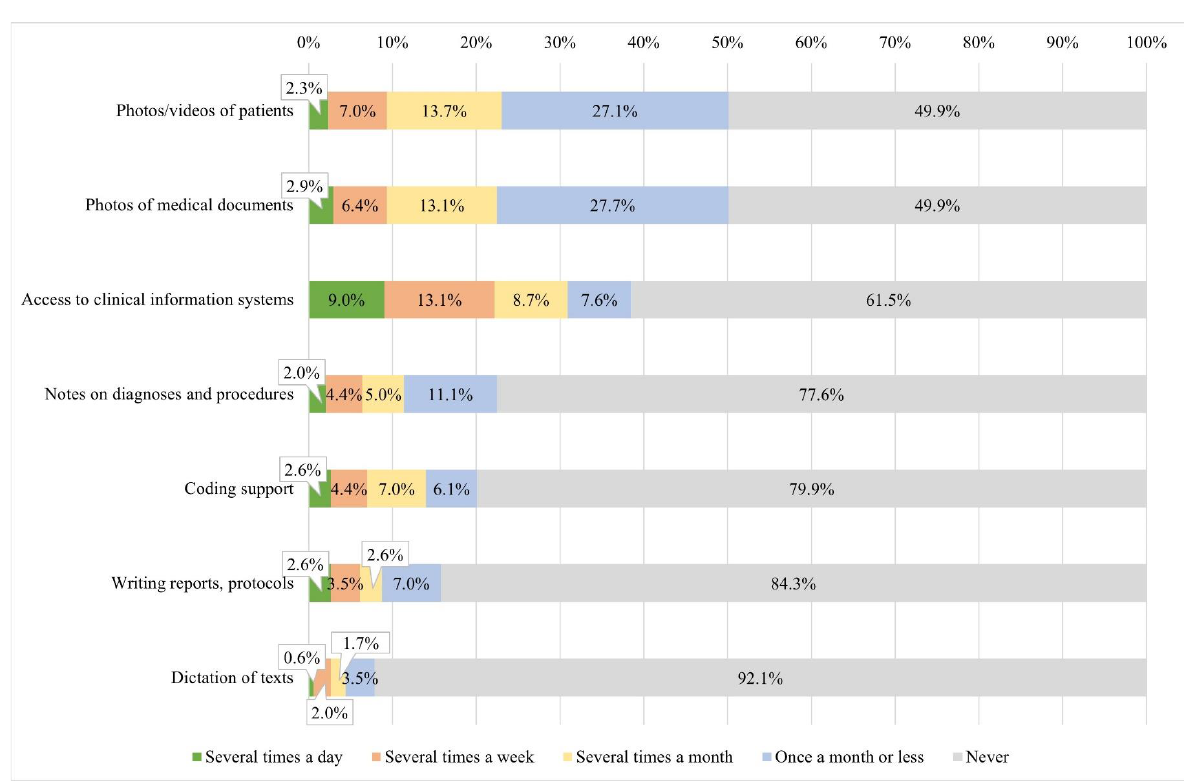
Figure A3. Organization. Int. J. Environ. Res. Public Health 2022 , 19 , x FOR PEER REVIEW